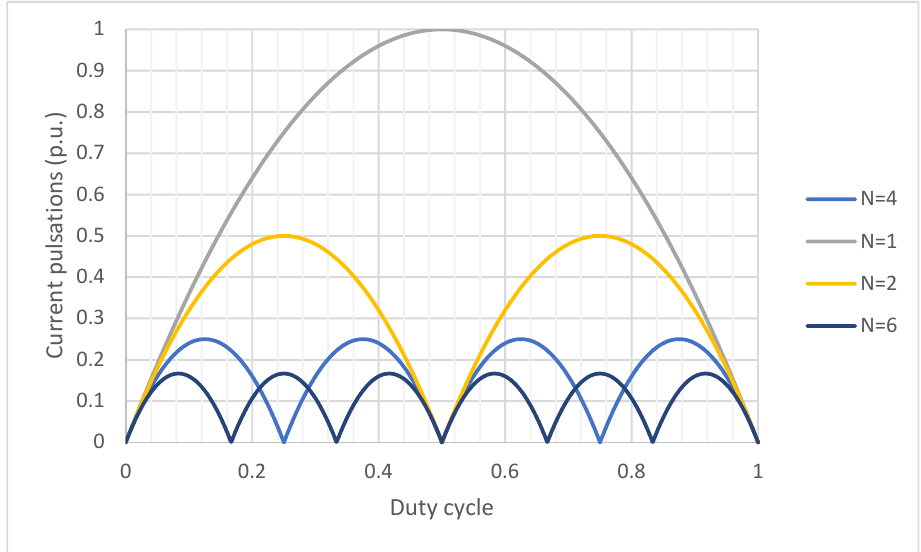
Figure 3. Relative current pulsations diagrams of interleaved bidirectional DC–DC converter for energy storage integration into DC microgrid.